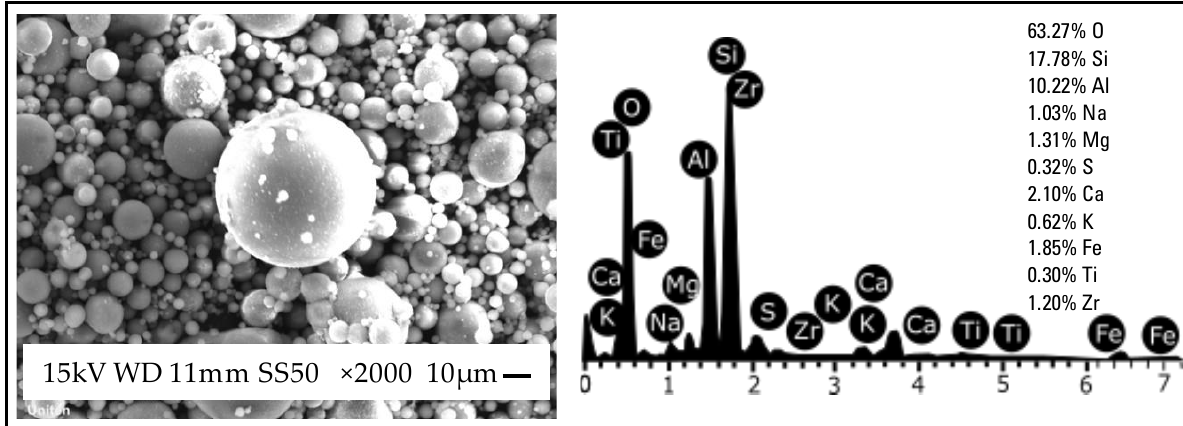
Figure 6. The SEM and EDX analysis of fly ash.